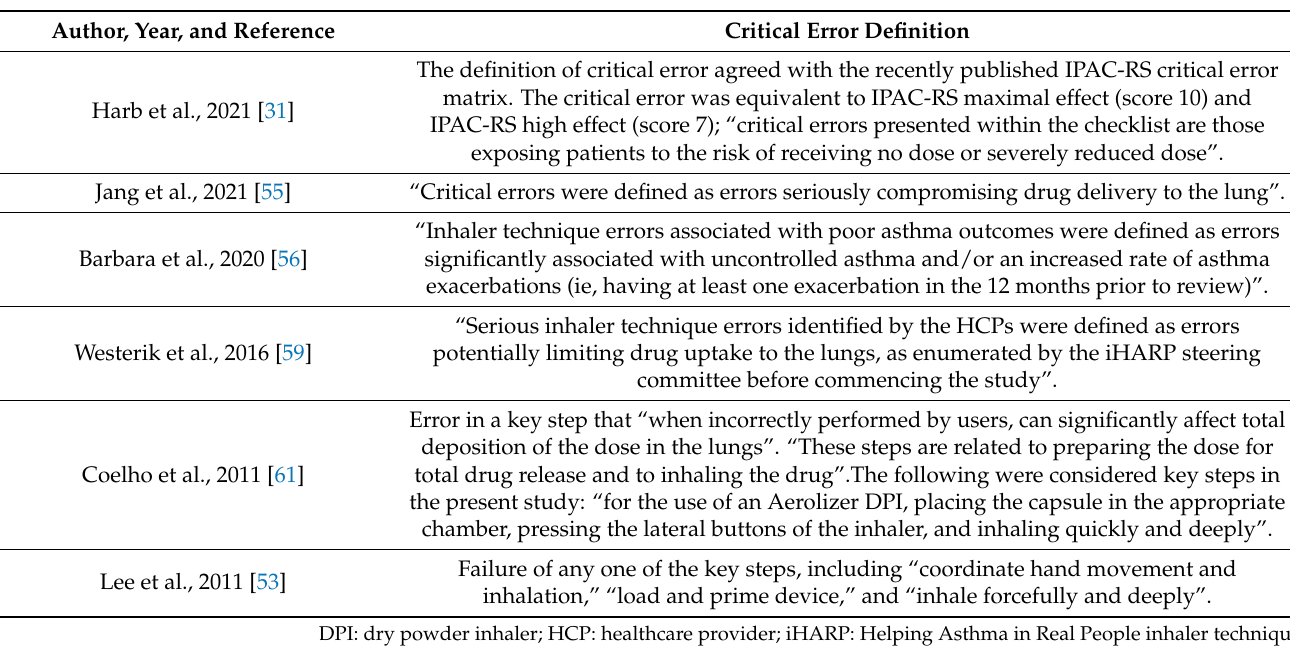
Table 2. Definitions of errors exposing patient to the risk of receiving a severely reduced dose or no medication being inhaled or reaching the lungs (referred to as critical errors), as reported in the included studies.